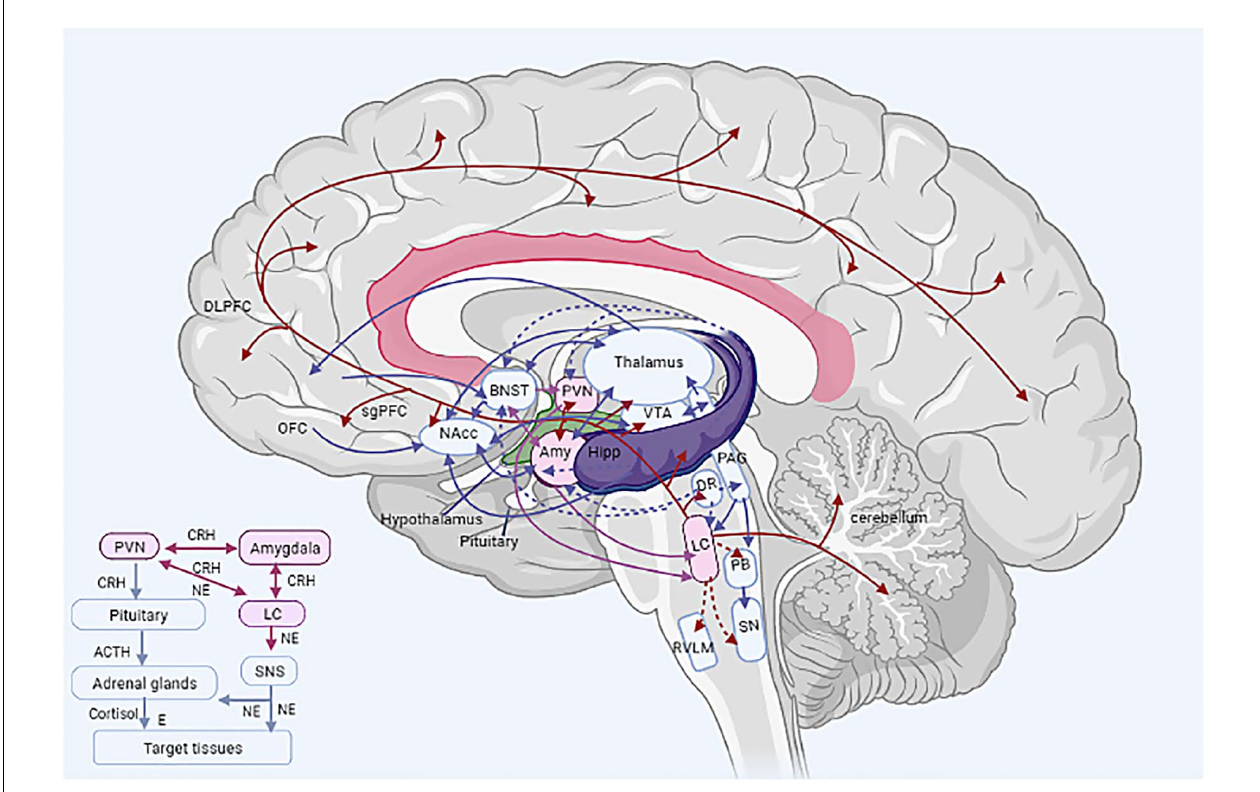
FIGURE 4 | The stress system. Main figure: central components of the stress system. Inset (bottom left corner): Simplified overview of the stress system (central and peripheral). ACTH, adrenocorticotropic-releasing hormone; Amy, amygdala; BNST, bed nucleus of the stria terminalis; CRH, corticotropin-releasing hormone; DLPFC, dorsolateral prefrontal cortex; DR, dorsal raphe nucleus; E, epinephrine; Hipp, hippocampus; LC, locus caeruleus; NE, norepinephrine; NAcc, nucleus accumbens; OFC, orbitofrontal cortex; PAG, periaqueductal gray matter; PB, parabrachial nucleus; PFC, prefrontal cortex; PVN, paraventricular nucleus of the hypothalamus; RVLM, rostral ventrolateral medulla; sgPFC, subgenual prefrontal cortex; SN, solitary nucleus; SNS, sympathetic nervous system; VTA, ventral tegmental area. Solid line arrows represent excitatory projections, whereas dashed line arrows represent inhibitory ones. Double-headed arrows represent reciprocal connections. Efferent LC pathways are depicted in